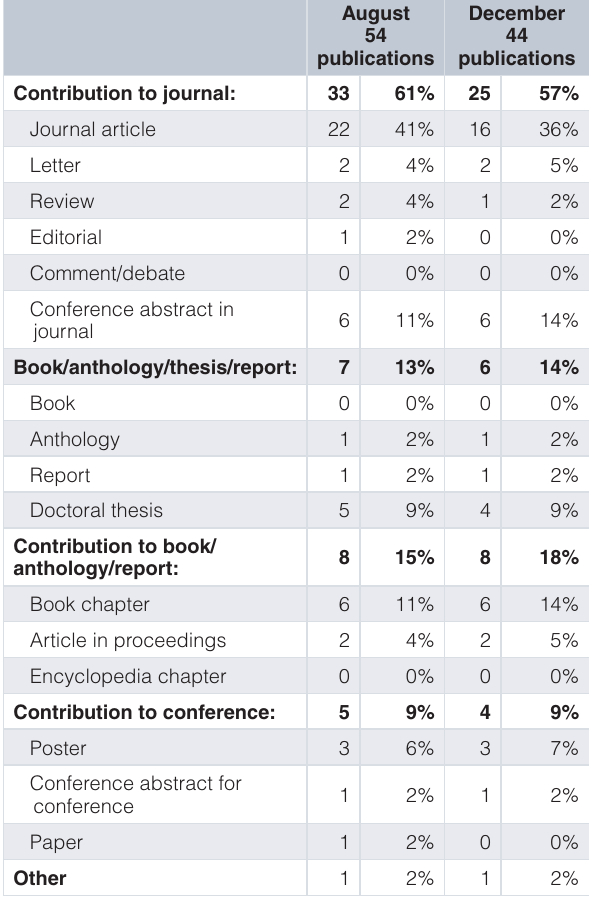
Table 5b. Publication type in Pure of publications with UID exported from Pure to SciVal and not matched. Download